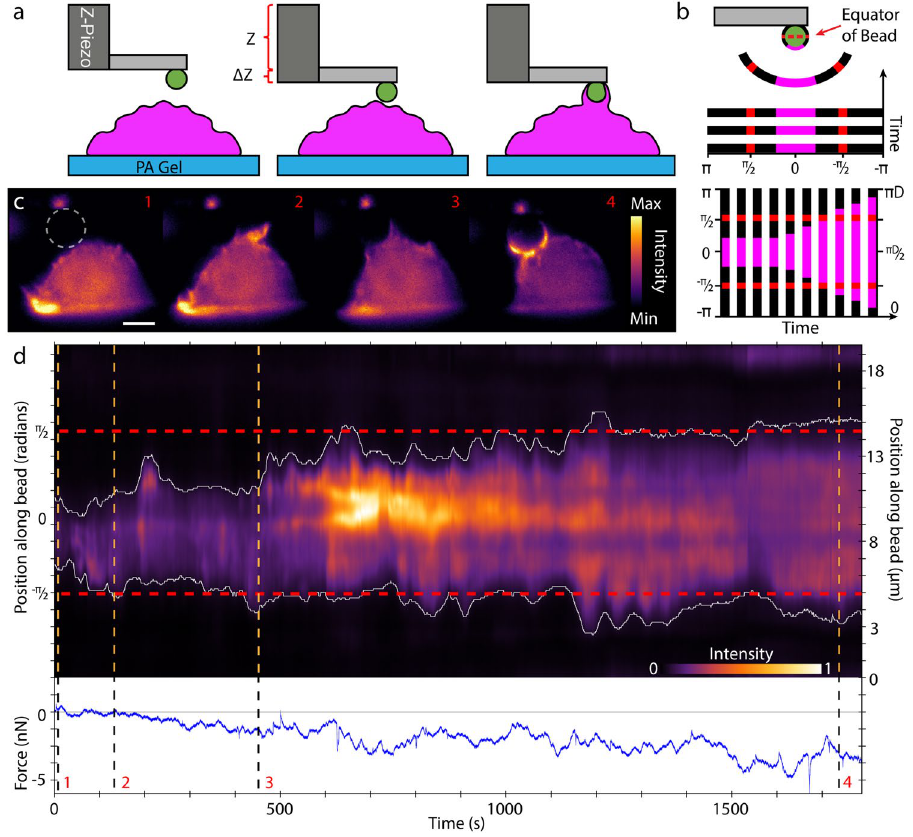
Figure 3. Side-view visualization and force characterization of phagocytic cup formation using LSFM and AFM. ( a ) A cartoon of the experimental procedure. The base end of the cantilever is lowered using the z-piezo such that the bead is located < 1 um above the cell. Holding the z-piezo position fixed for a 30 min dwell, the cell is imaged in side view and forces are measured as the macrophage attempts to engulf the bead. We note that the bead is affixed to the much larger cantilever and therefore cannot be fully engulfed. ( b ) A circular kymograph is formed by drawing a 5 pixel thick circle around the bead circumference and plotting the average intensity across this 5 pixel line vs. position along the circle. The unfurled intensity plots for each image frame are then put together in a kymograph as depicted in bottom representation of b. The red dashed line marks the equator of the bead tip. ( c ) A fixed LS image sequence of the RAW 264.7 cell stably expressing HaloTag F-tractin labeled with JaneliaFluor 549 and illuminated using a 561 nm vertical line Bessel light sheet (see also Supplementary Video 3). Each image corresponds to its labelled orange dashed line in ( d ): 1, the cell before phagocytic cup formation, 2, at initial cup formation, 3, point where cup reaches the bead equator, 4, mature cup showing punctate actin. Scale bar = 5 µ m. Bead tip was coated in AlexaFluor488-conjugated IgG, and was imaged in a separate channel with 488 nm laser (bead channel not shown). Each channel was imaged for 300 ms with 100 ms delay between channels. ( d ) Circular kymograph depicting the actin intensity around the bead tip over the course of the experiment (retraction data not shown). Note for intensity scale for ( d ) is optimized for clarity and does not correspond to that of c . Position along circumference is represented in radians on left axis and in µ m on right axis. The dashed horizontal red lines in the kymograph represent the equator of the bead. The white lines represent the edge of the phagocytic cup, taken as 11% of the maximum intensity. Lower part of the kymograph represents the right side of the